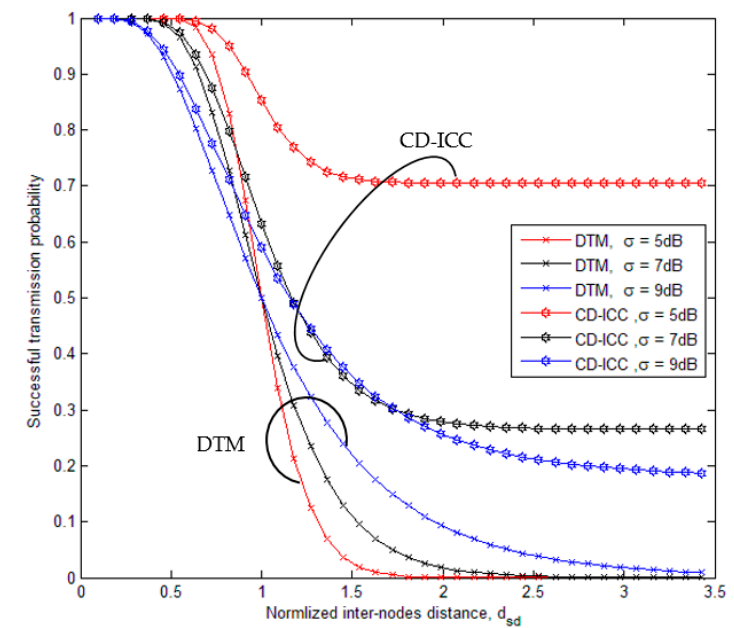
Figure 3. Comparison of successful transmission probability of DTM and CD-ICC with normalized inter-node distance, ρ is 3.5, ξ min is 6, and ξ max is 7. Sensors 2018 , 18 , 3661